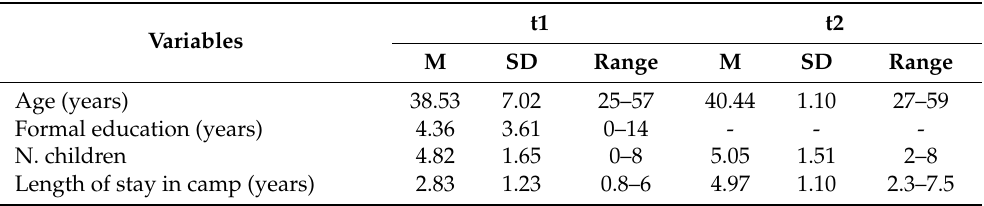
Table 1. Socio-demographic information of the sample, N =